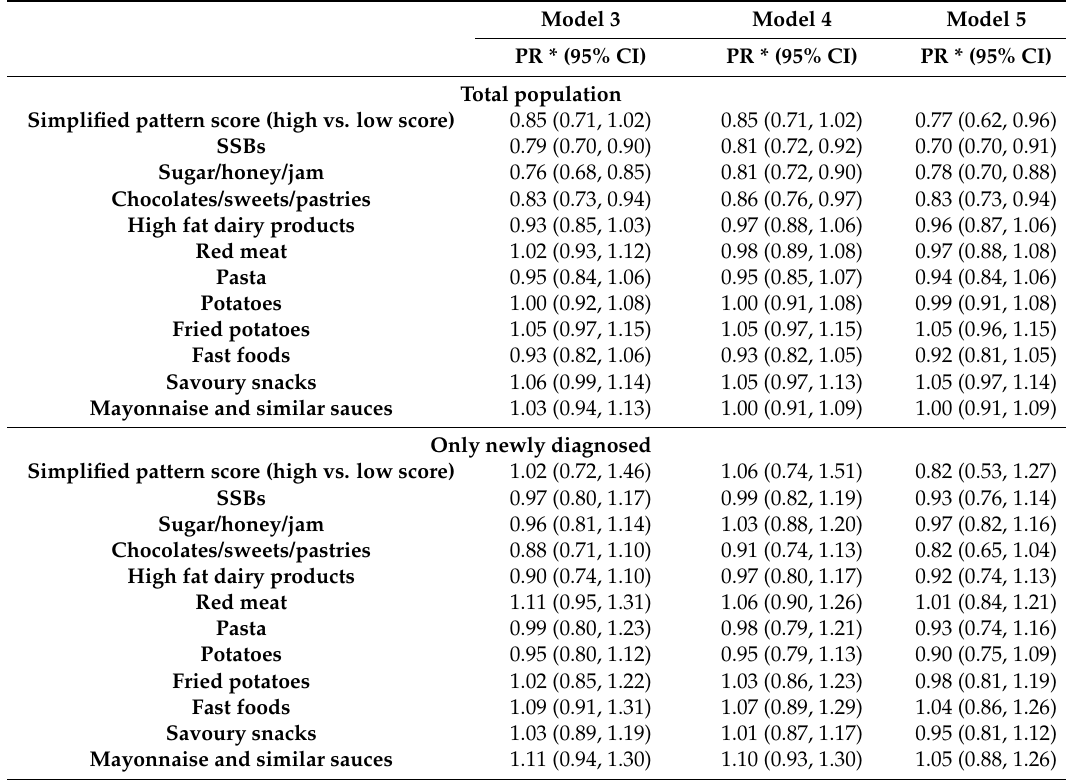
Table 4. Association between the simplified HSHF pattern score, individual key elements, and T2D.